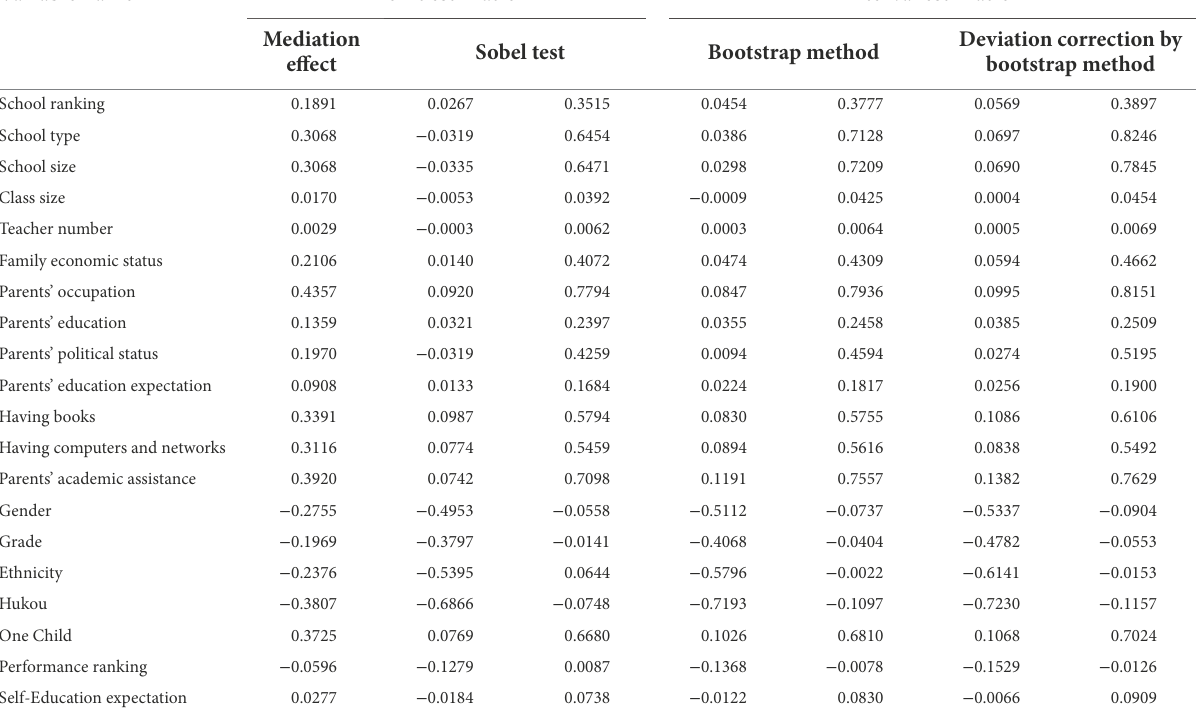
TABLE 5 Mediation effect of shadow education (math